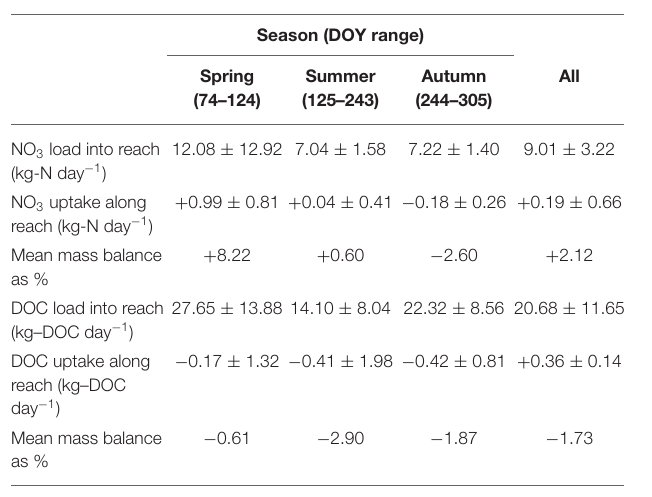
TABLE 3 | Seasonal patterns in daily NO 3 -N and DOC load to the study reach and removal/release rates along the reach.